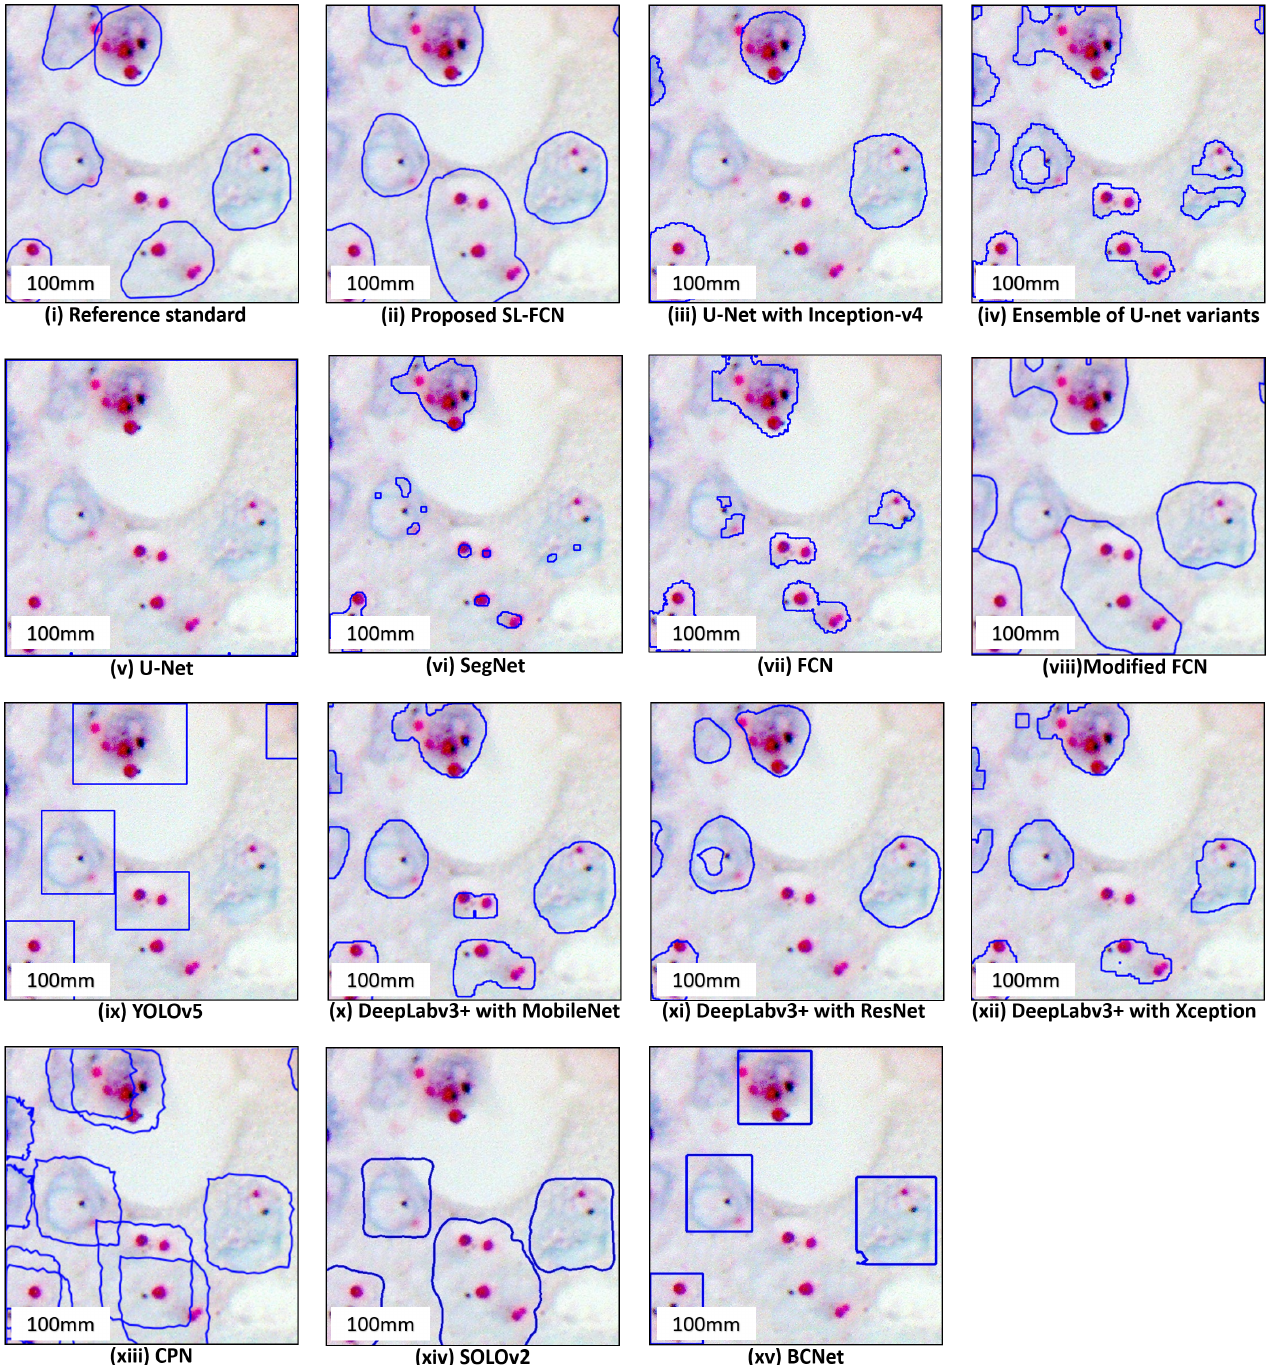
Figure 4. Qualitative segmentation results of the proposed SL-FCN method and the baseline methods for segmentation of HER2 amplification in DISH dataset